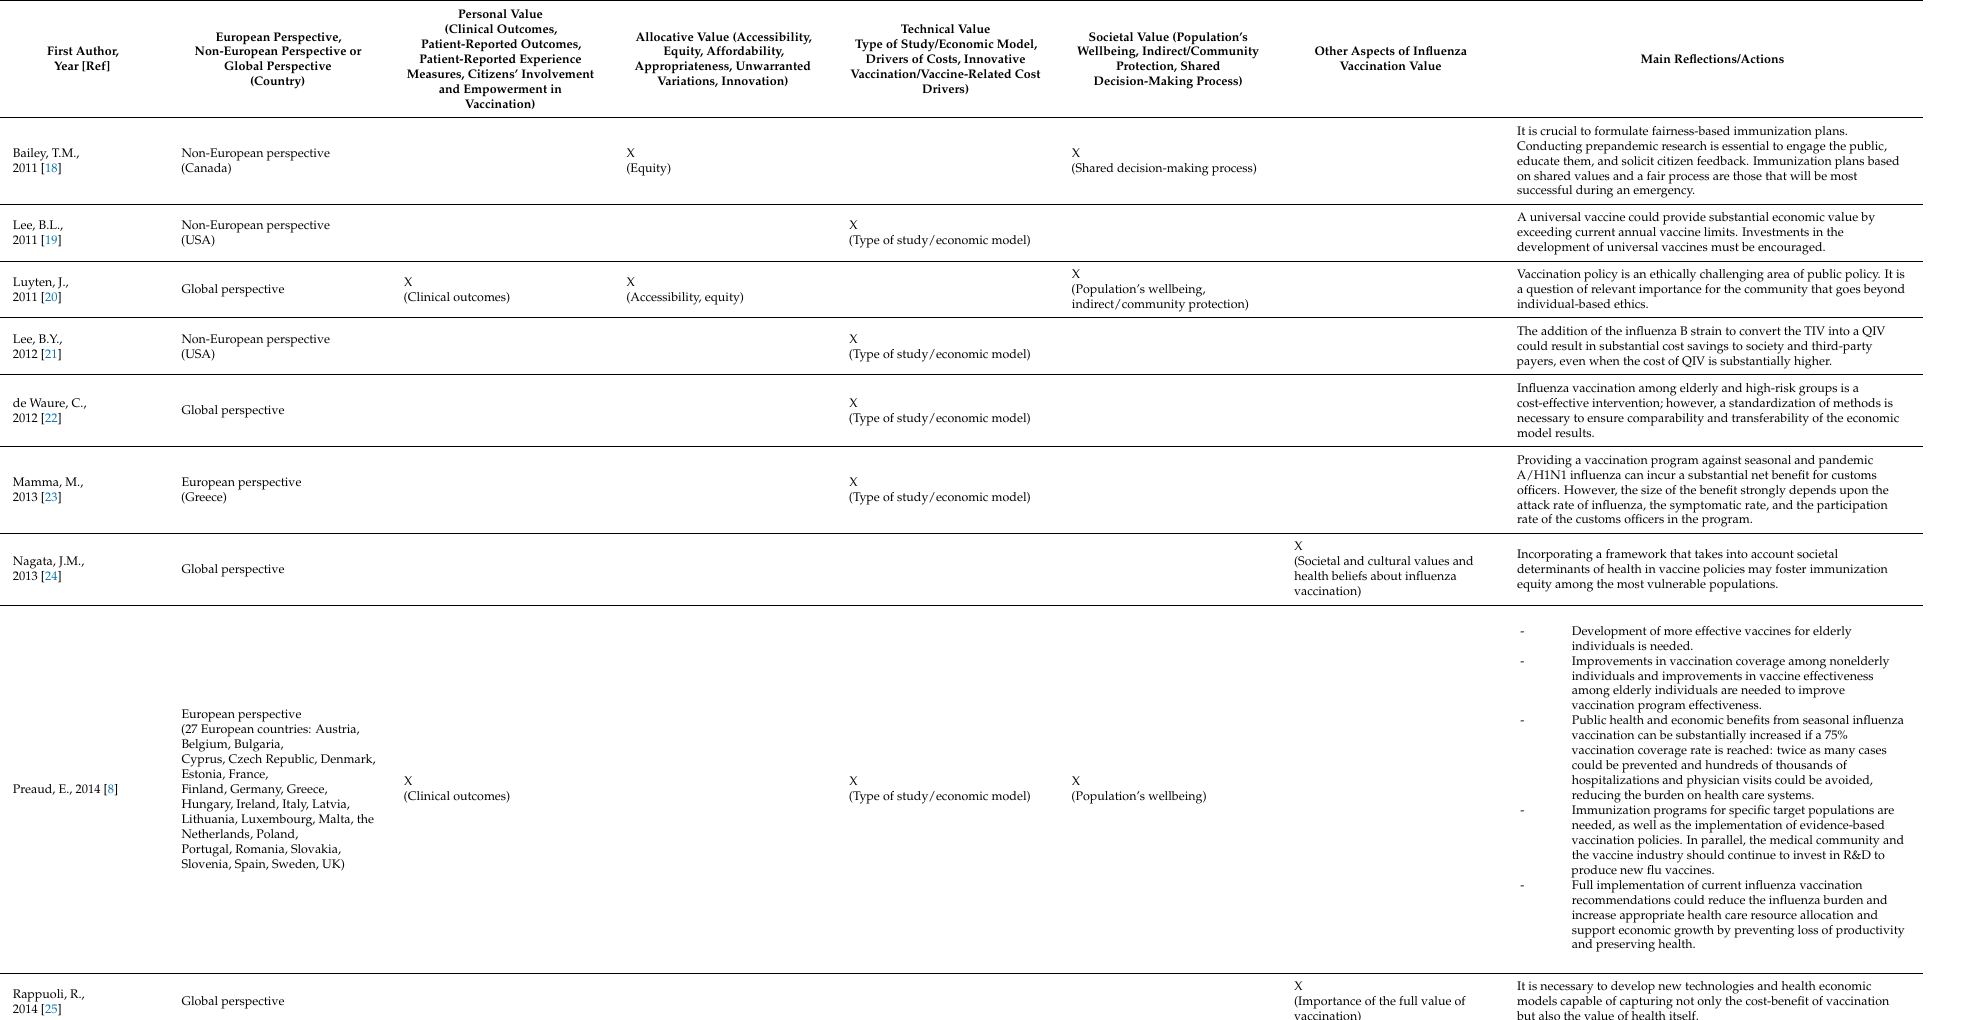
Table 2. Main findings on influenza vaccination values of the included